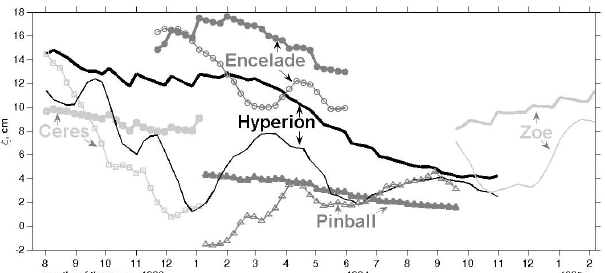
thick grey line with crosses) and of surface peak relative vorticity ( ω 0 – grey line with filled-in circles), of ratio ω 0 /ω m (solid black line with diamonds) and of ratio R m /H (dashed black line, not in the scale). The X-axis gives the names of the meddies listed in Ta- ble 2. (b) . Observed ratio ω 0 /ω m (solid line), predicted ratio from Eq. (9) (dash-dotted black line). The error bars represent the root- mean square error, computed assuming errors in N of 10%, in H of 100m and in R m of 3km. The buoyancy frequency was obtained from the climatic monthly mean density fields (WOA09).